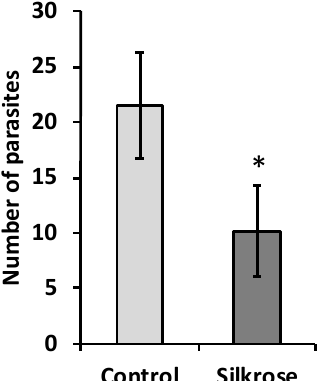
Figure 4. Effect of silkrose treatment on the number of Benedenia seriolae parasites per individual yellowtail at aquaculture field site. Results are presented as mean ± standard error. Asterisk indicates statistically significant differences compared with control group (* p < 0.05).